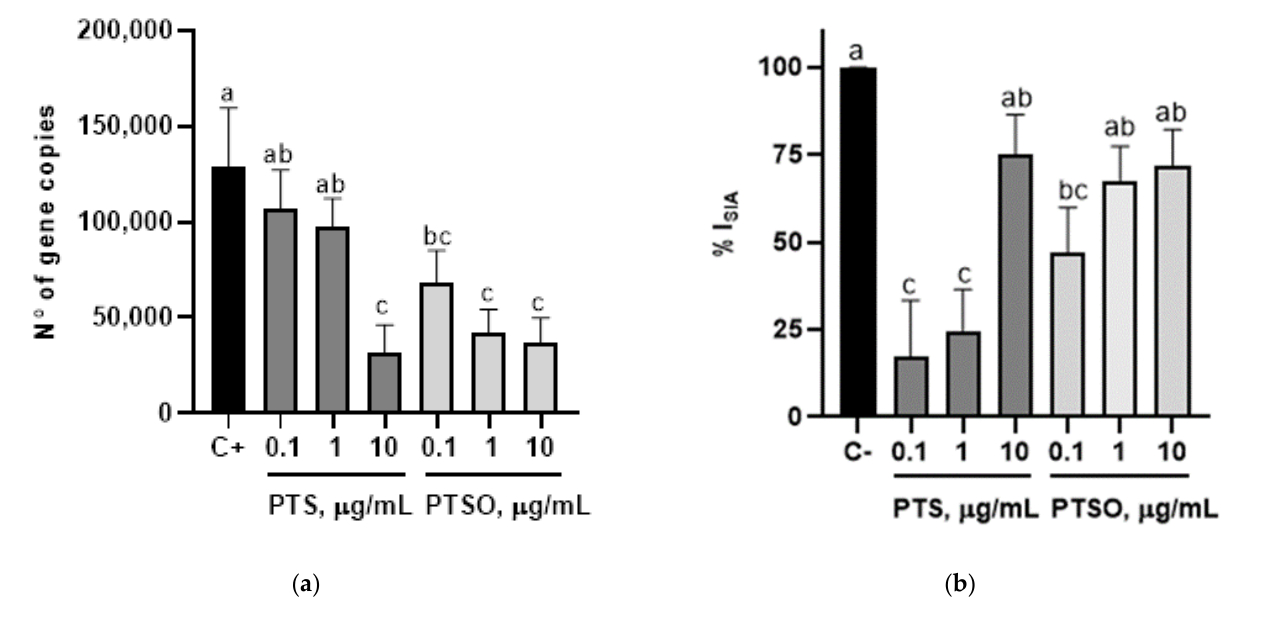
Figure 2. Effect of compound concentration on the estimated abundance of sporozoites, as estimated from qPCR: ( a ) number of E. acervulina gene copies detected in MDBK cells 24 h after the infection with sporozoites incubated at different PTS or PTSO concentrations; ( b ) percentage of inhibition of sporozoite invasion in MDBK cells when E. acervulina sporozoites were incubated at different PTS or PTSO concentrations; C+, MDBK cells infected with E. acervulina sporozoites that were not incubated with the compounds. Different letters between columns indicate significant differences at p < 0.05.